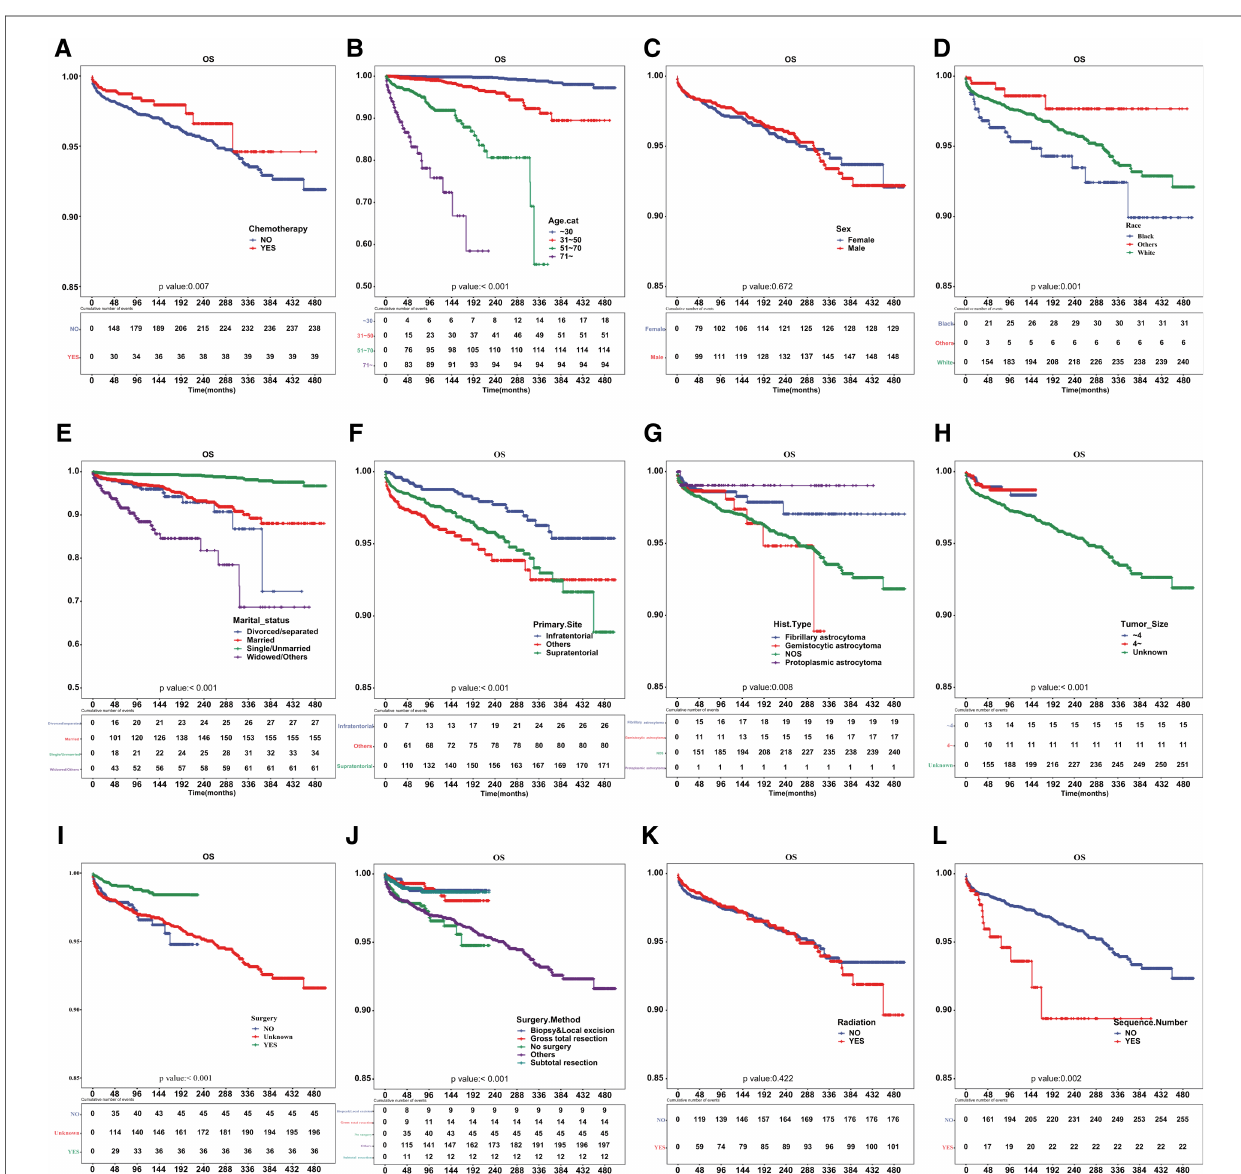
FIGURE 1 Cardiac disease-speci fi c survival curve according to patient characteristics. Cardiac disease-speci fi c survival curve of ( A ) chemotherapy, ( B ) age, ( C ) sex, ( D ) race, ( E ) marital status, ( F ) primary site of tumor, ( G ) histologic type, ( H ) tumor size, ( I ) surgery, ( J ) surgical method, ( K ) radiotherapy and ( L ) sequence